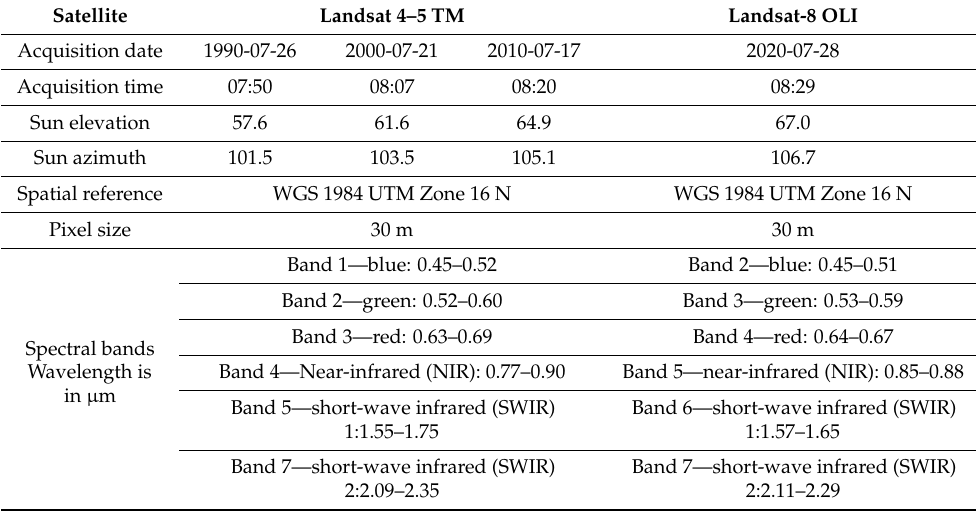
Table 1. Landsat data acquisition, spatial and spectral